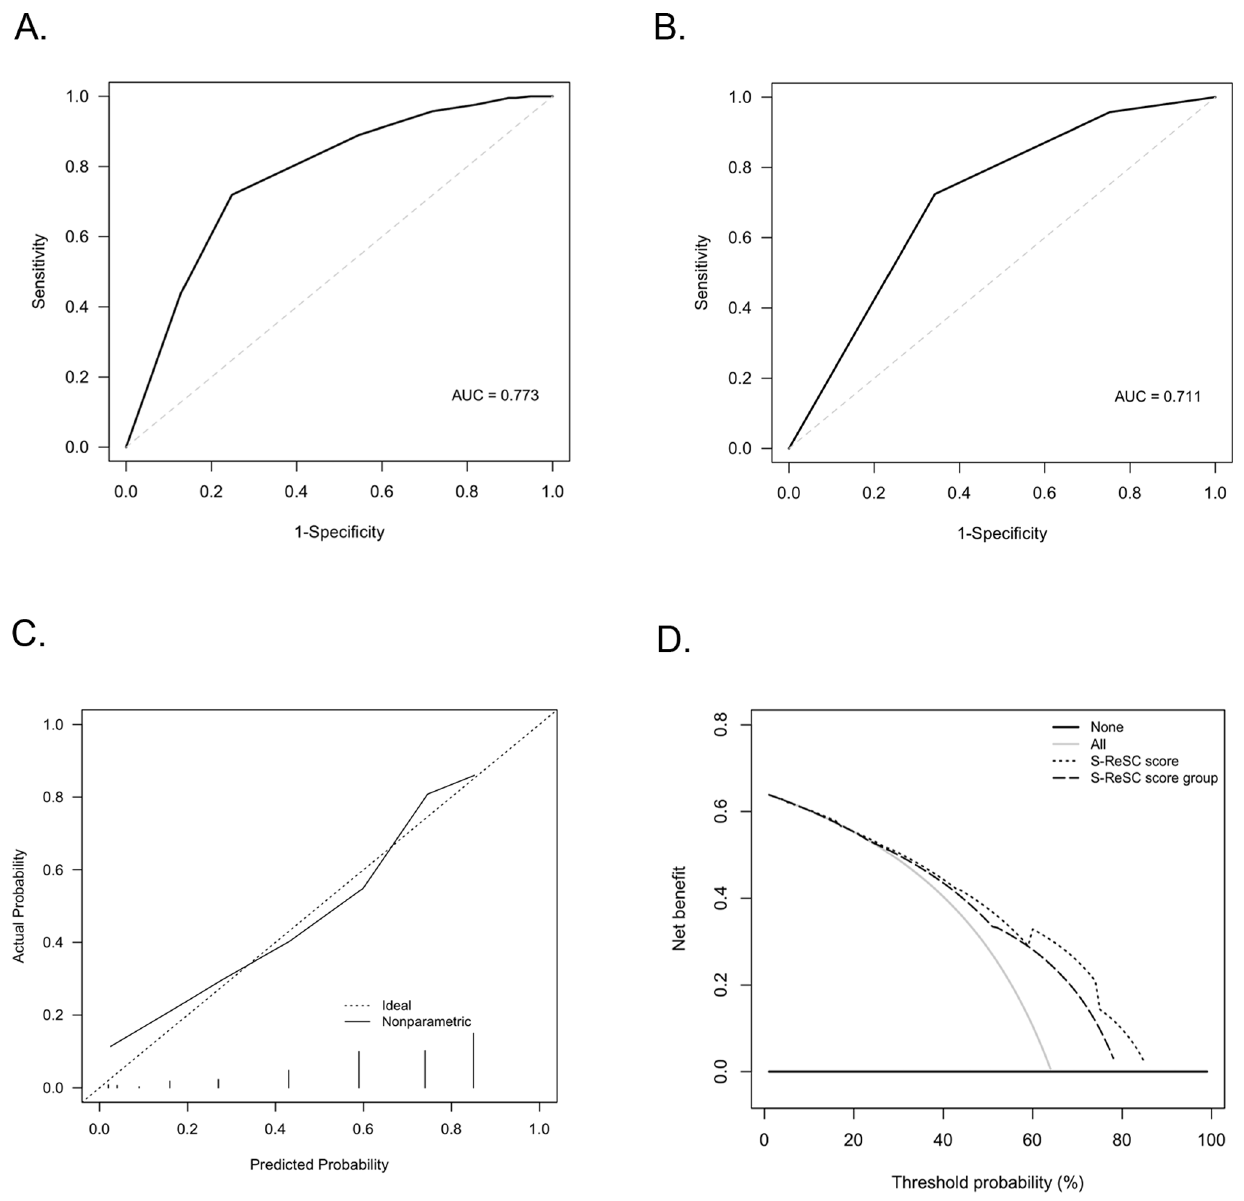
Figure 1. external validation of S-ReSC scoring system. A, ROC curve of S-ReSC scoring system. B, ROC curve of 3-titered S-ReSC score subgroups. C, a calibration plot to show the predicted probability of stone free rate. D, a decision curve analysis revealed that the prediction model provided a superior net benefit using S-ReSC scoring system.